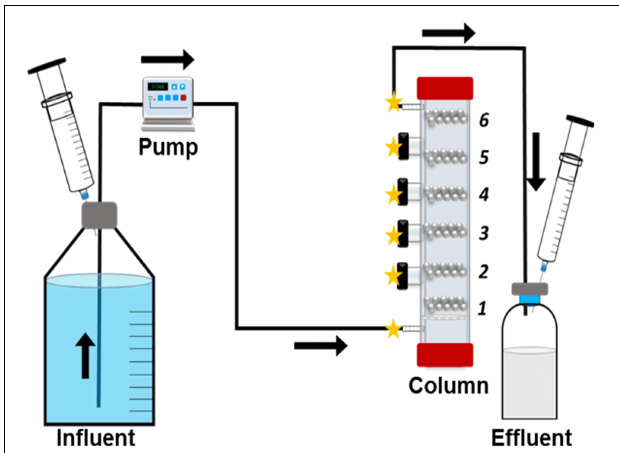
FIGURE 1 | Schematic overview of the flow through system. Column sections (1–6) and possible sampling points (stars) are identified.